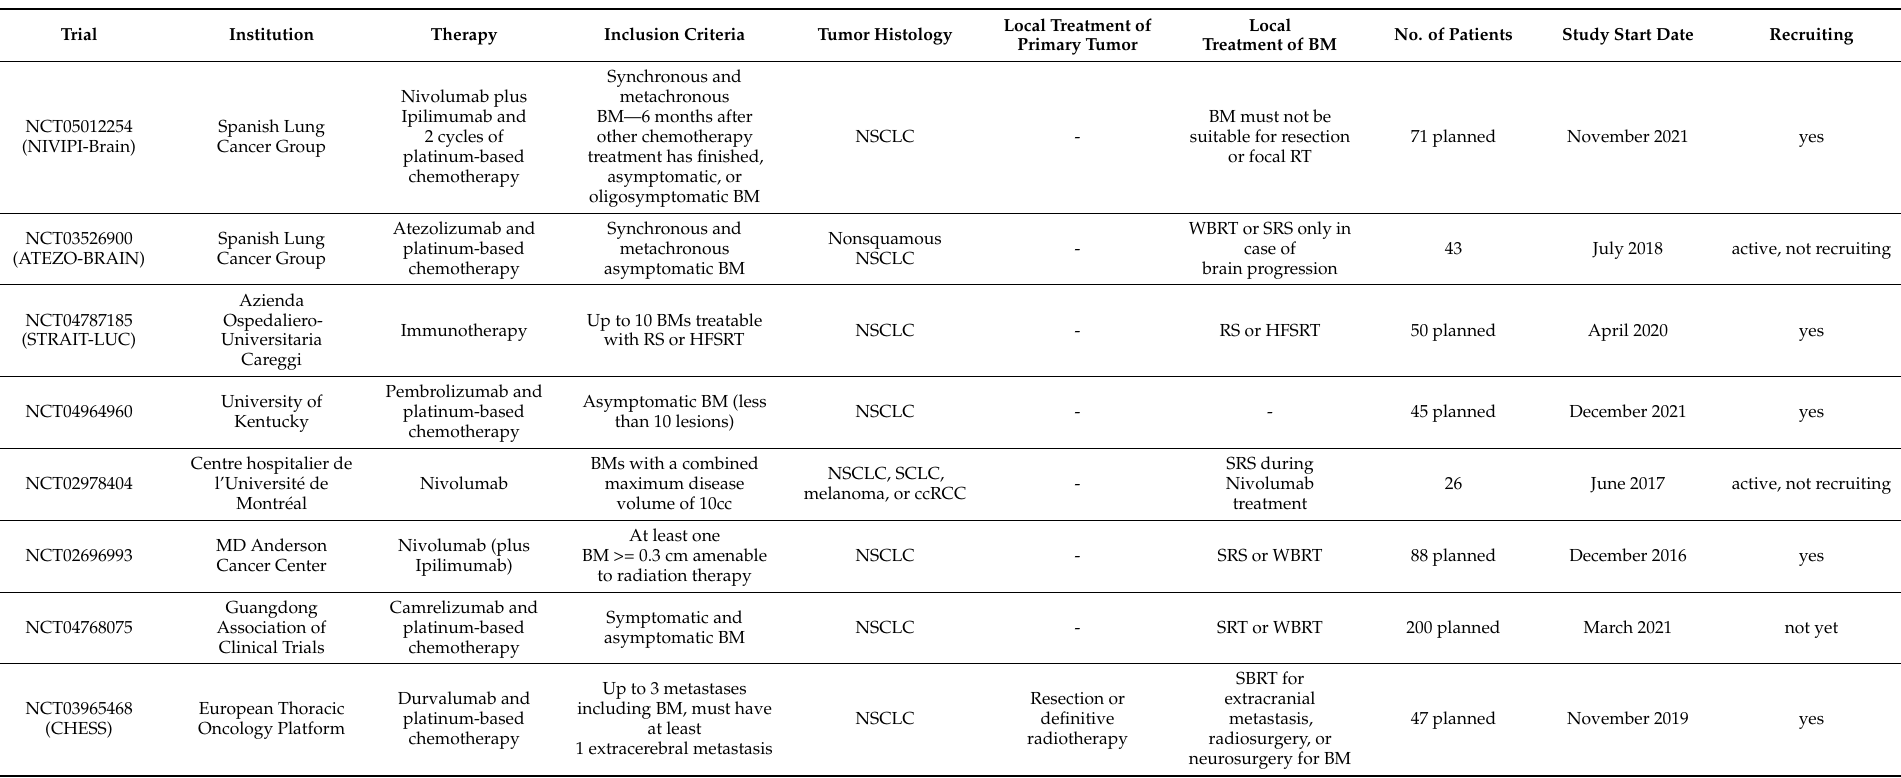
Table 2. Overview of the current clinical trial landscape for NSCLC patients with brain